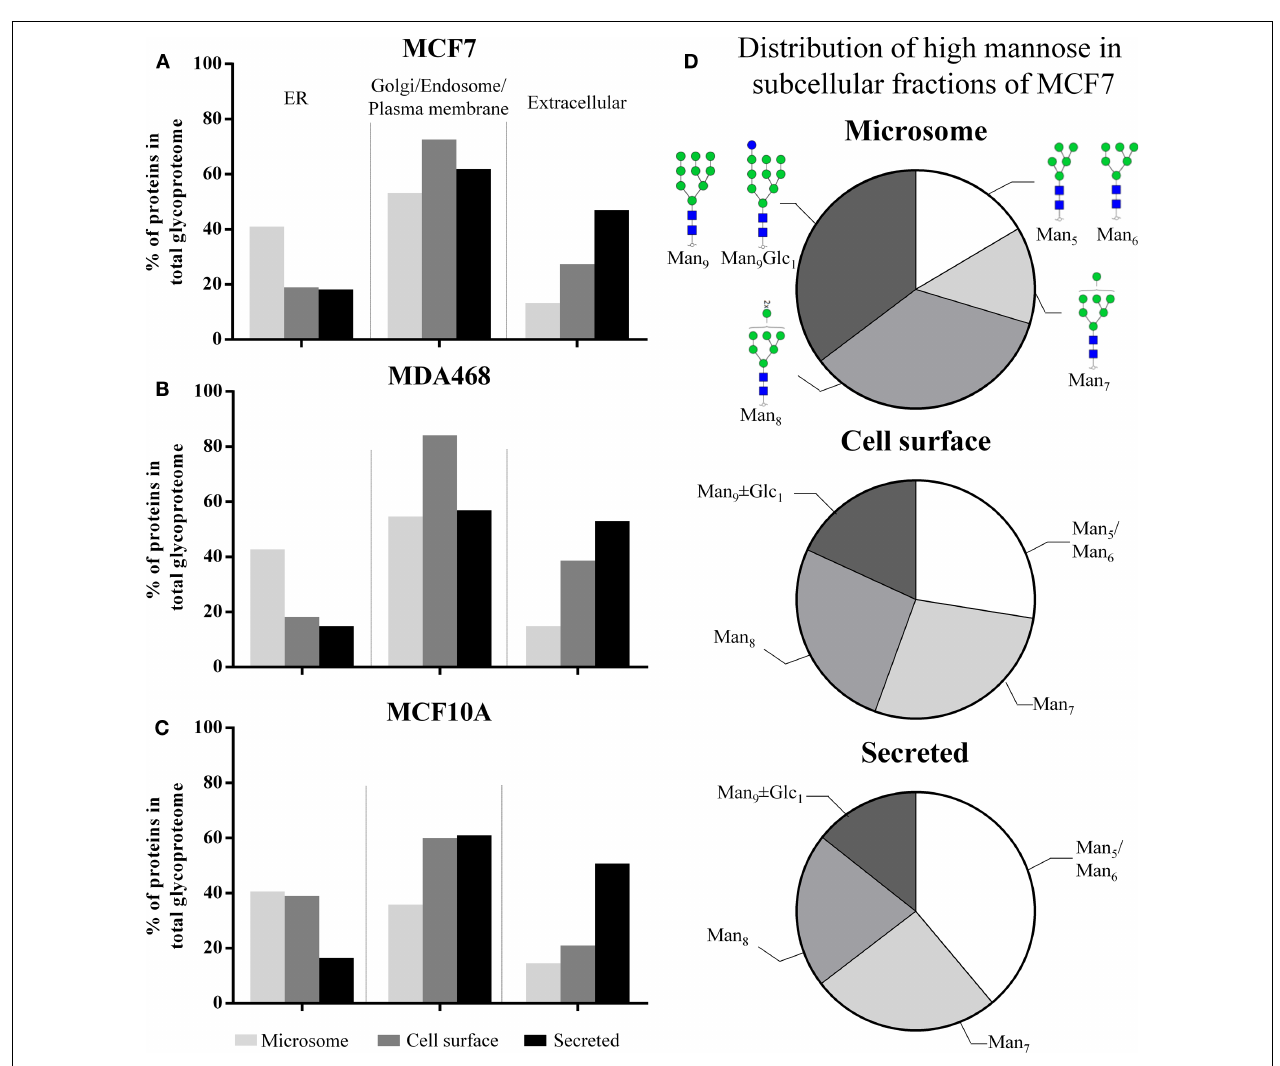
proteins. (D) The subcellular distribution of the high-mannose glycan type series on proteins derived from MCF7 into Man 5 , Man 6 , Man 7 , Man 8 , Man 9 ± Glc 1 , the latter representing immature N -glycans normally only associated with intracellular ER N -glycosylation. See Figure S2 in Supplementary Material for the subcellular distribution of the high-mannose glycan type series of MDA468 and